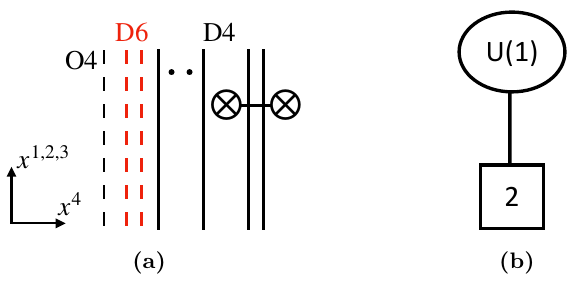
Figure 14. (a): the brane configuration for the monopole screening contribution to the v = e n − 1 + e n sector in T V · T V . (b): the corresponding quiver